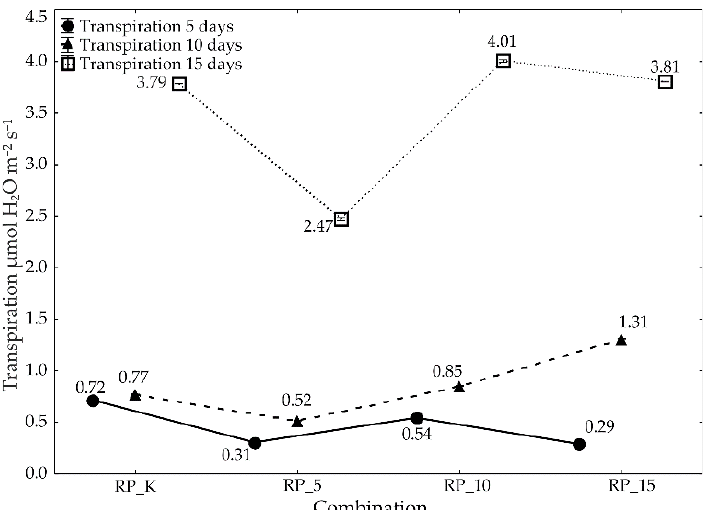
Figure 5. Intensity of transpiration at the set time intervals in winter wheat with different numbers of foraging aphids of R. padi . Vertical lines at mean values indicate SE.